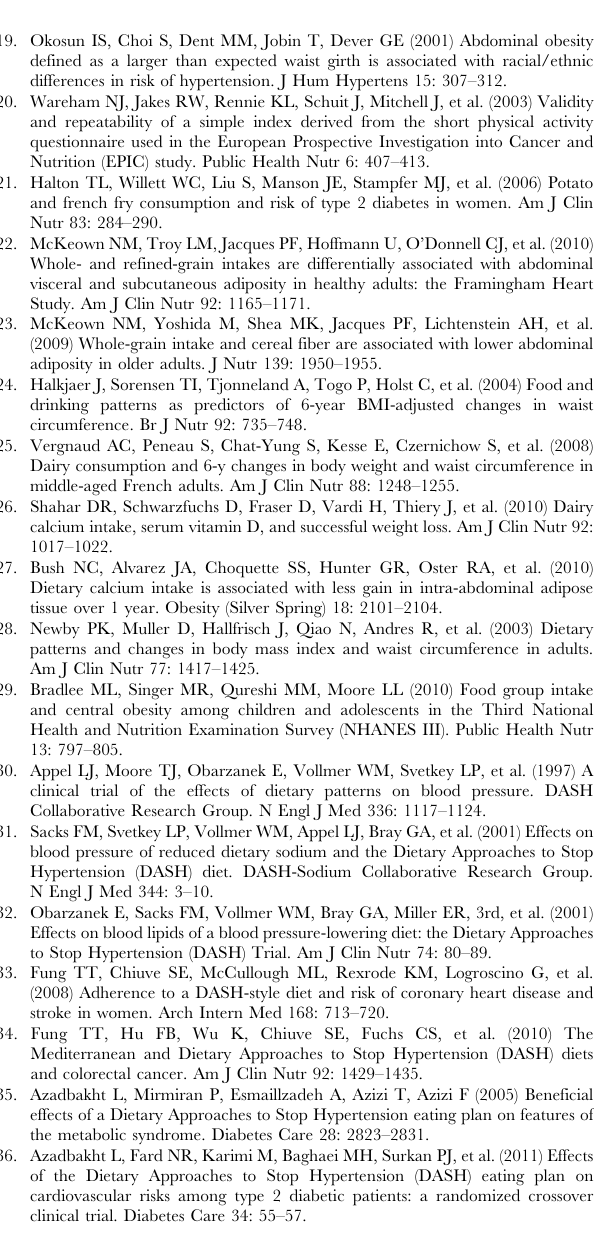
Table S1 Consumption of food groups/items (g/d) by gender and centre in participants of the EPIC-DiOGenes